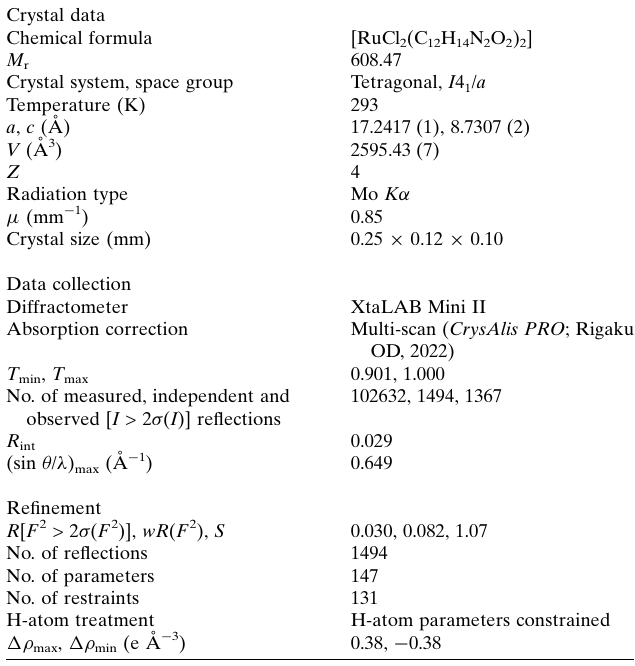
Table 1 Experimental details.